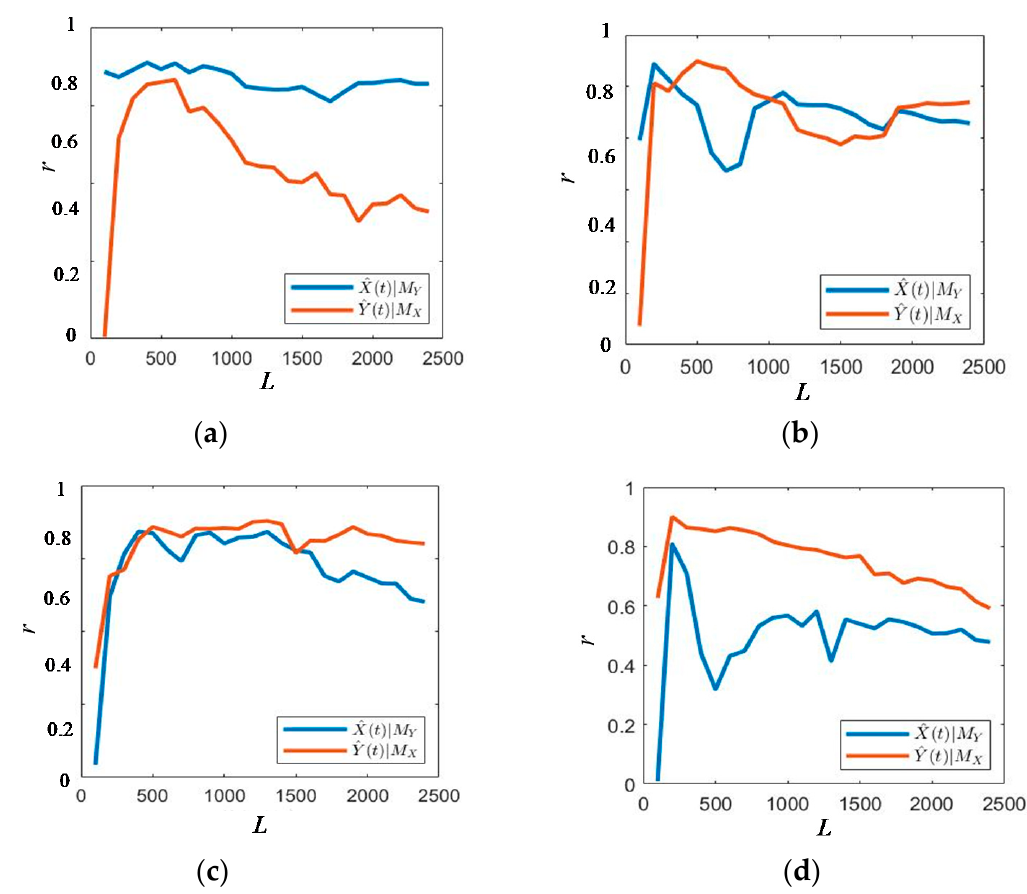
Figure 13. Convergent cross-mapping situation. ( a ) Mx – My > 0.3, ( b ) Mx–My < 0.1, ( c ) 0.1 < Mx–My < 0.3, Mx > 0.5, and ( d ) 0.1 < Mx–My < 0.3, Mx < 0.5.